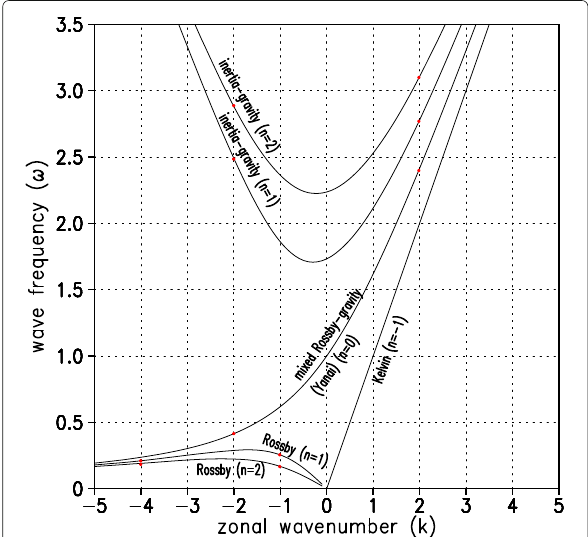
Fig. 1 Dispersion relation of free equatorial waves for a given meridional number n , as given by Eq. (12). Axes have been √ β ∗ c ∗ for wave frequency ω and by non-nondimensionalized by √ β ∗ / c ∗ for zonal wavenumber k . The reddots locate the parameters used to produce the 10 panels in Figs. 2 and